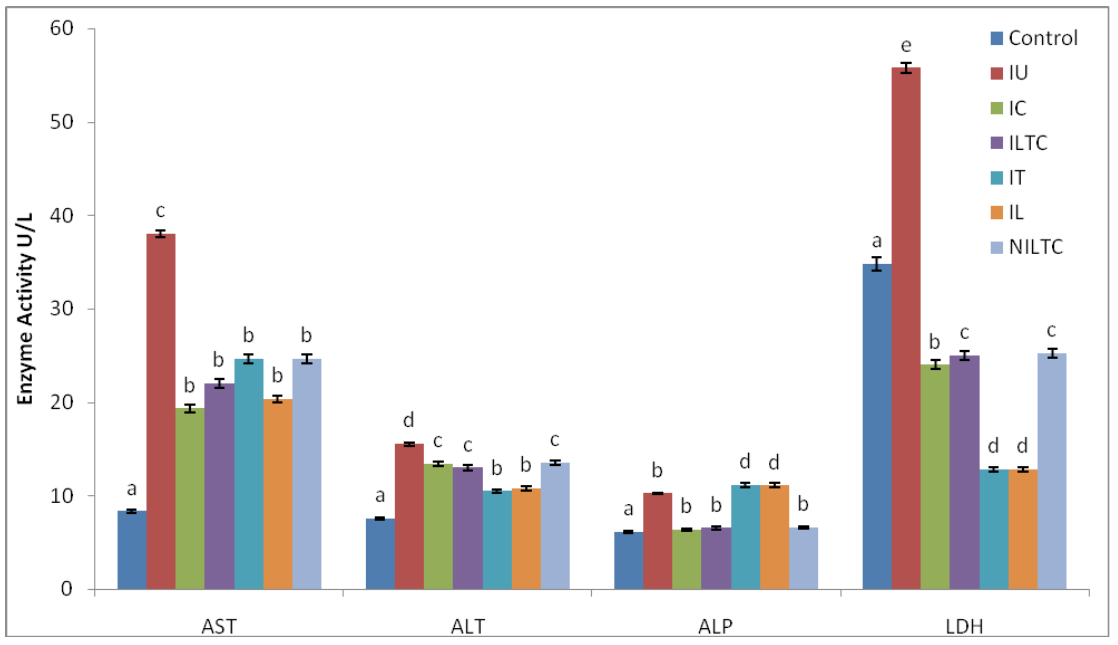
Figure 2: The effect of lumefantrine, trimethoprim, and lumefantrine-trimethoprim-copper complex on the activity of AST, ALT, ALP and LDH in the plasma of P. berghei NK-65 infected mice. Values are mean of 5 replicates ± SEM. Bars with different superscript are significantly (p < 0.05)